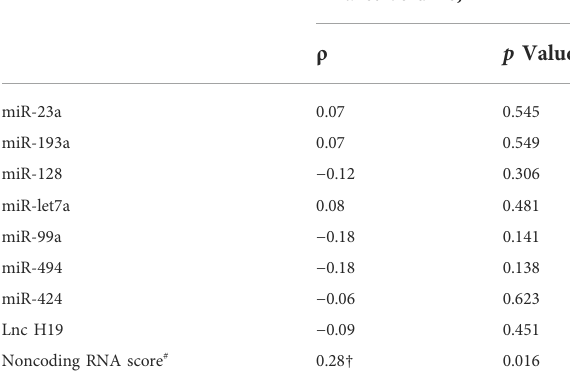
TABLE 4 Bivariate correlation between noncoding RNAs and noncoding RNA score and the infarct volume in the subgroup of patients with available infarct volume ( n = 72).